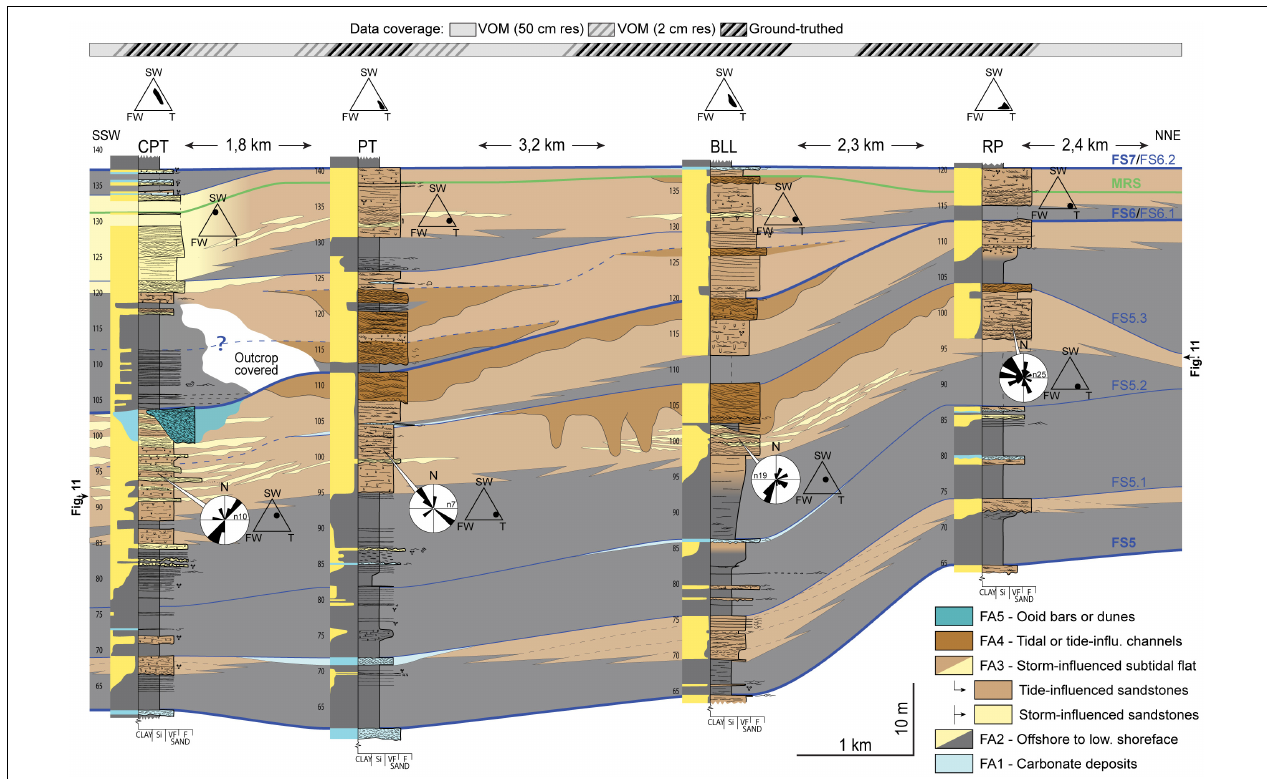
FIGURE 10 | Correlation panel of the maximum regressive unit; panel position is indicated in Figure 9 correlation panel; colors correspond to FAs as indicated by legend; relative content of sand (yellow), mud (gray), and carbonate (blue) is indicated by lithologic columns to the left of each log trace; FS, flooding surface; MRS, maximum regressive surface. Bold font type corresponds to regional stratigraphic surfaces; decimal numbers correspond to subordinate and local flooding surfaces; blue dotted lines refer to subordinate flooding surfaces (interpreted from facies correlation and not from VOMs), and outcrop data coverage is indicated at top. VOM, virtual outcrop model; CPT, Cerro Pampa Tril; PT, Pampa Tril; BLL, Barranca Los Loros; RP, Río Pequenco ( Figure 1D ). FA3 paleocurrent data and ternary diagram plots for FA3 bedsets included (modified from Dashtgard et al., 2012). SW, storm wave; FW, fair-weather wave; T,